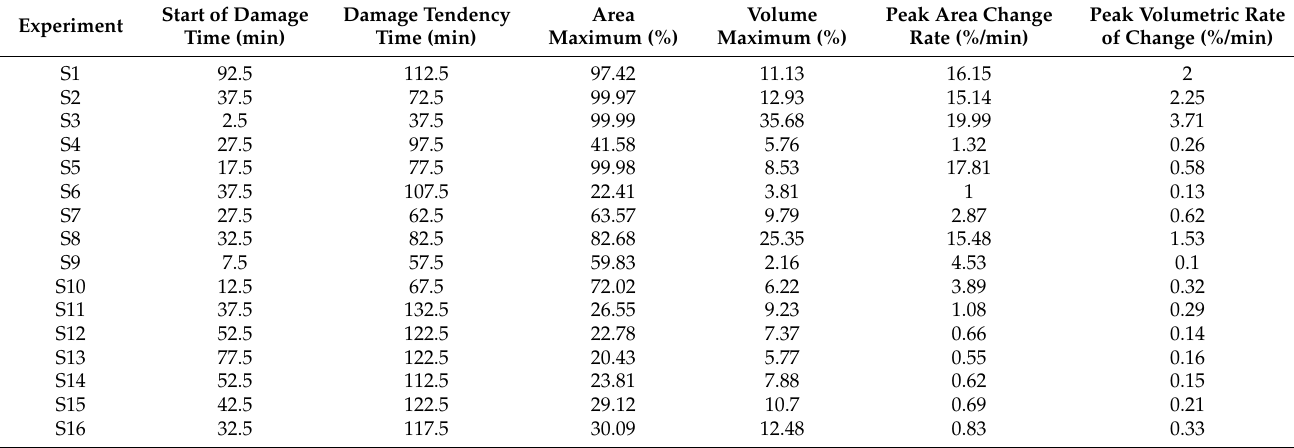
Table 2. Experimental damage characteristic